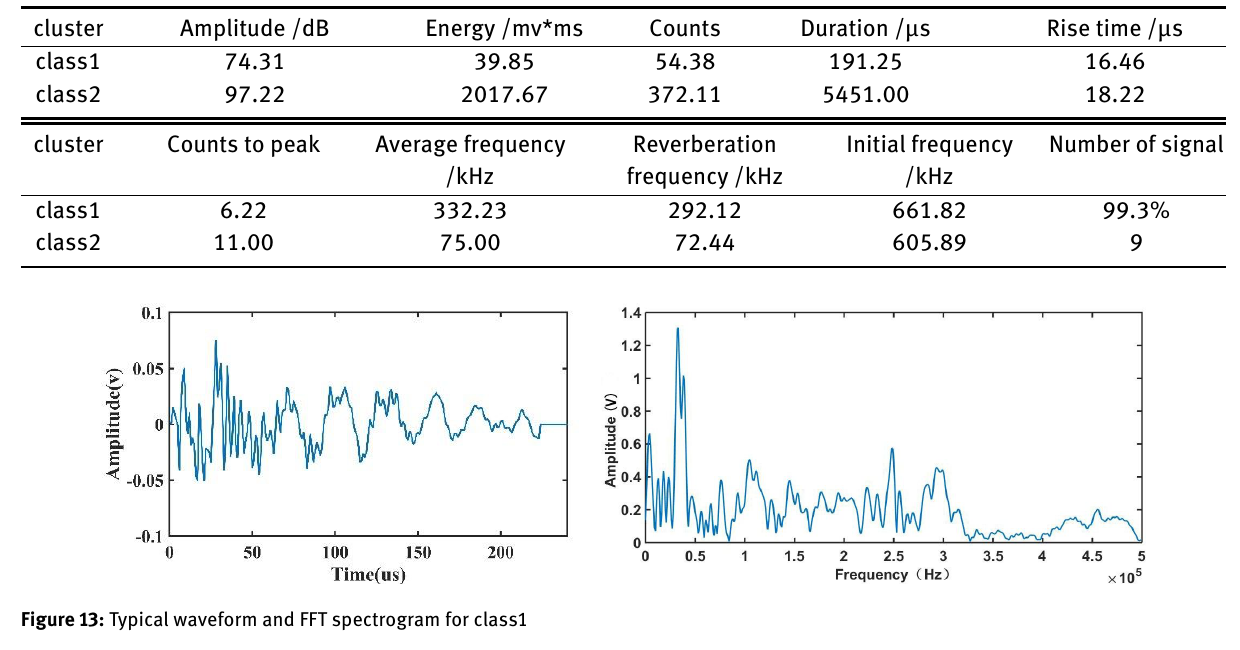
Figure 13: Typical waveform and FFT spectrogram for class1